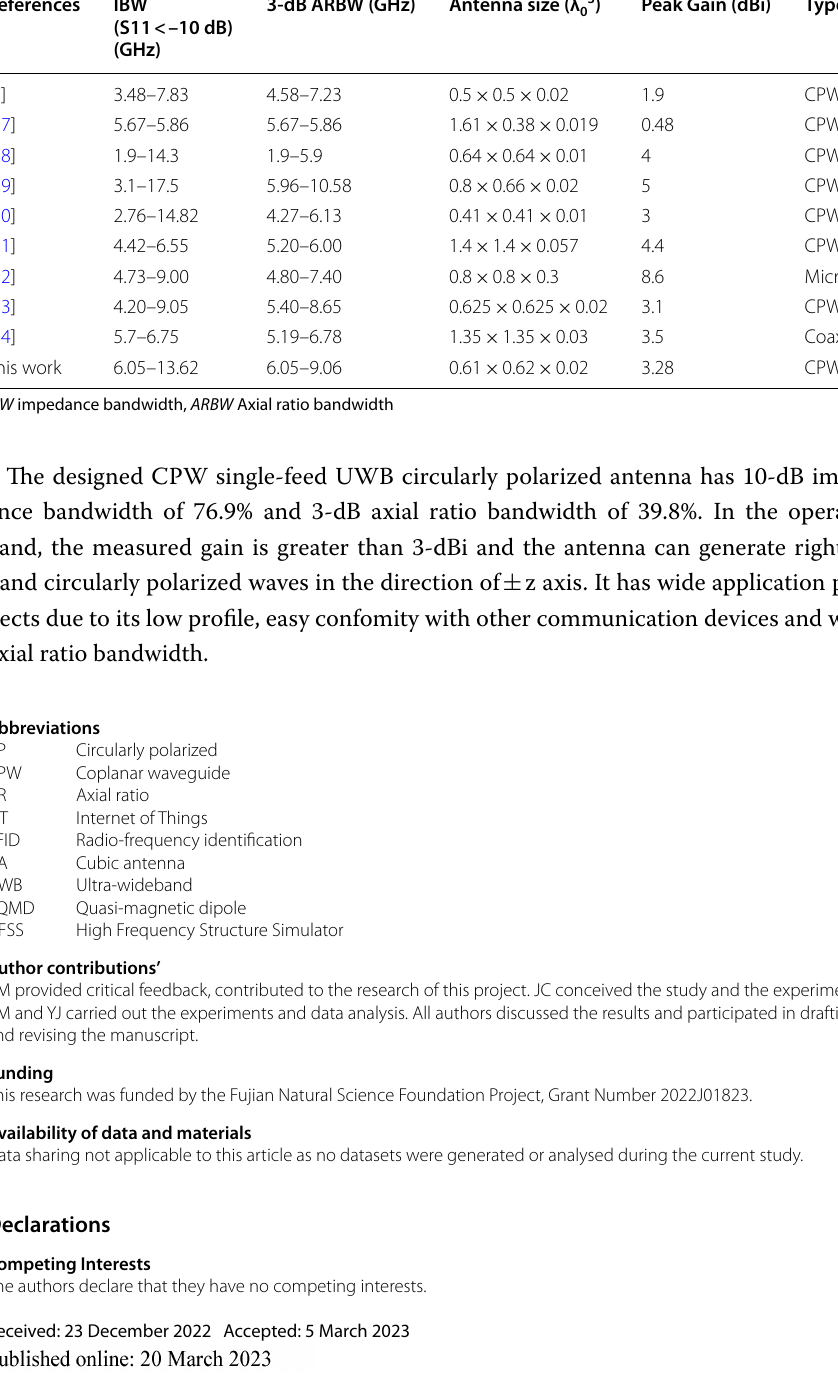
Table 2 Comparison with the published CP antennas